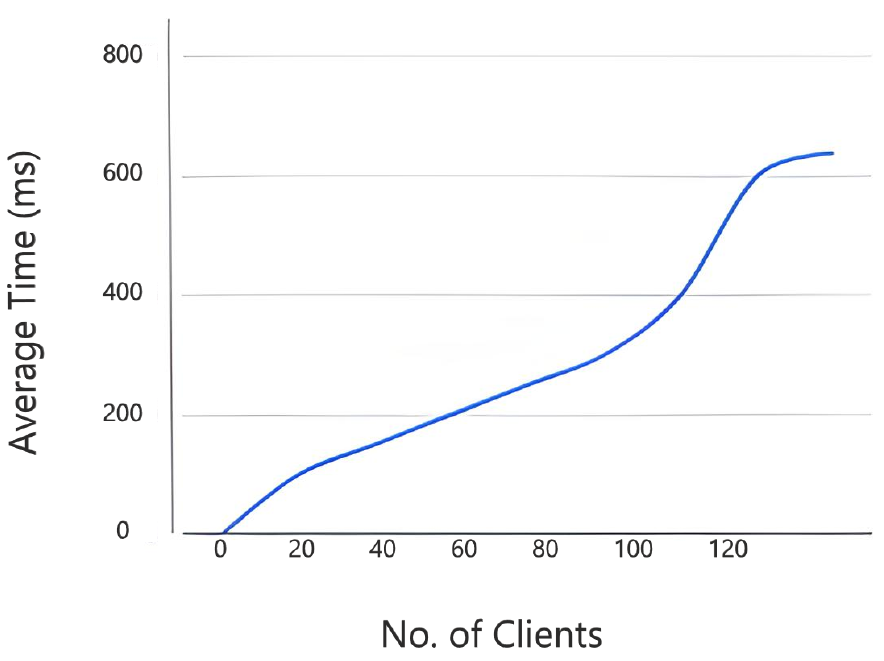
Figure 13. Average time to accomplish the DTLS handshake.